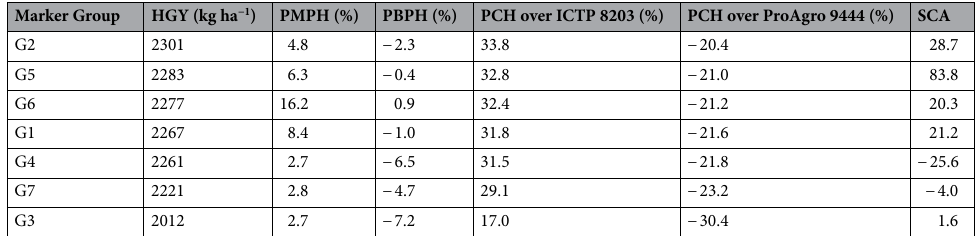
Table 10. Mean grain yield of all the population hybrids when the representative parental population of each marker group were crossed to the rest of the marker groups, along with PMPH, PBPH and PCH in pearl millet. HGY , Hybrid grain yield, PMPH Panmictic mid-parent heterosis, PBPH Panmictic better parent heterosis, PCH Panmictic commercial heterosis, SCA Specific combining